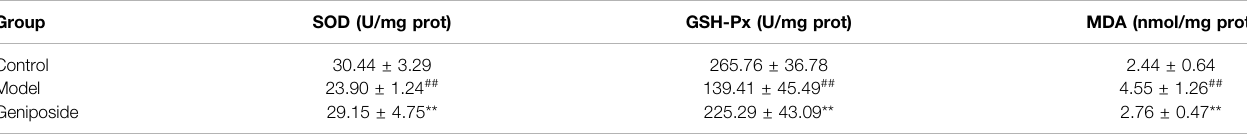
TABLE 3 | SOD, GSH-Px activities, and MDA levels in liver homogenates after geniposide treatment. Group